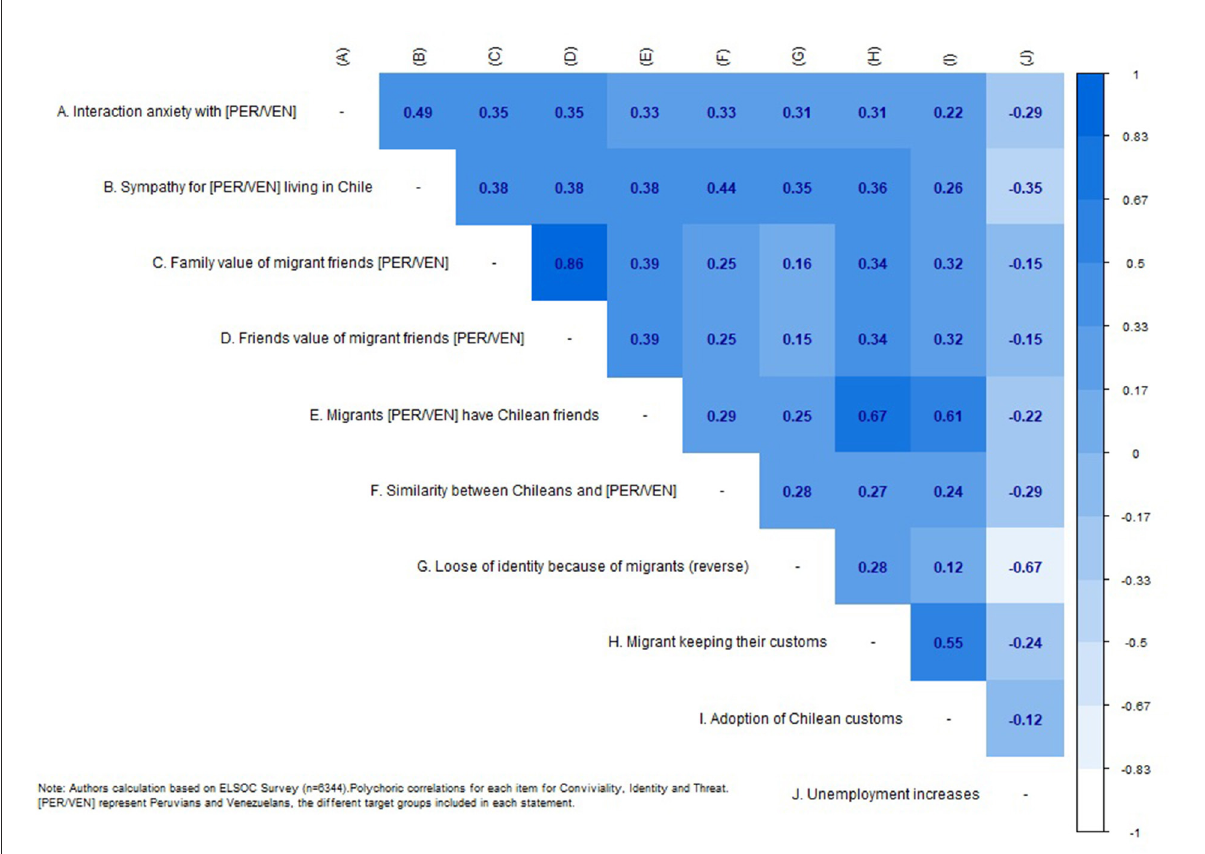
FIGURE2 Polychoric correlation matrix for convivial/conviviality, identity, and threat